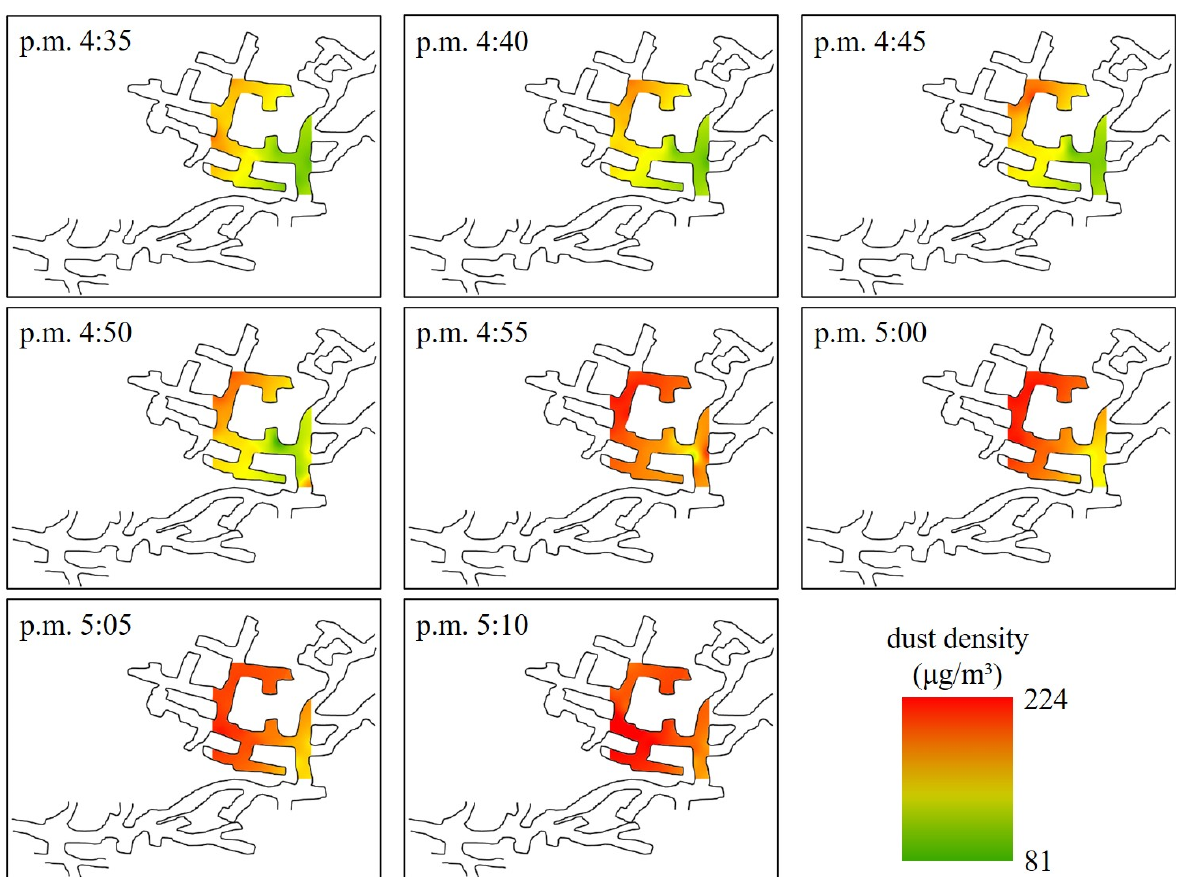
Figure 10. Spatial distribution of dust measurement results at 5 min intervals in the drift of Samdo Mine.